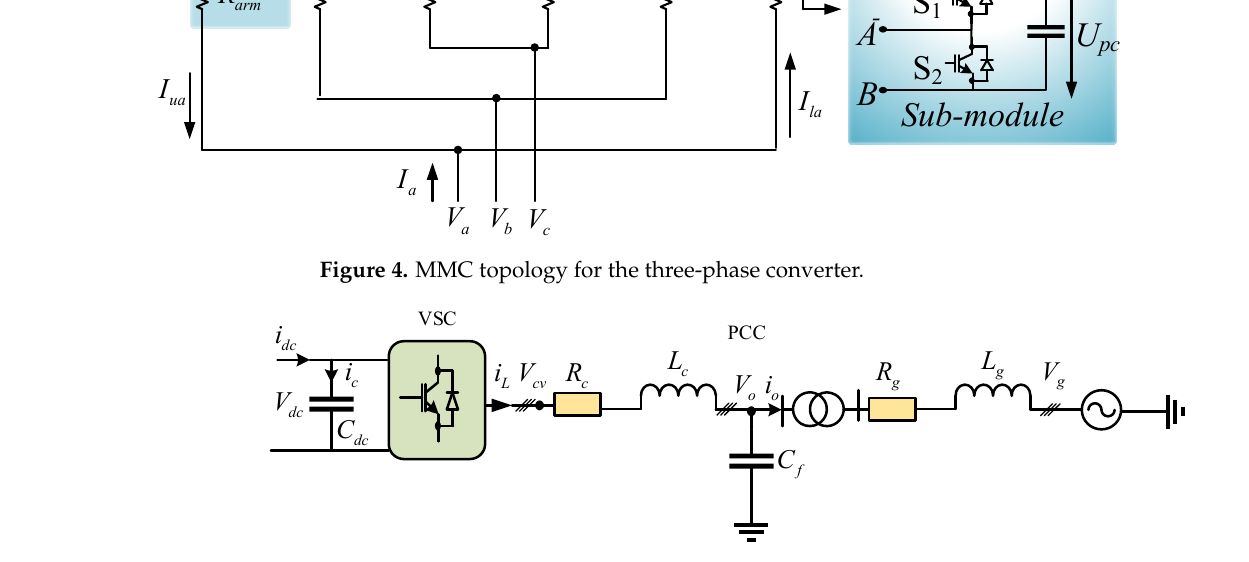
Figure 4. MMC topology for the three-phase converter.